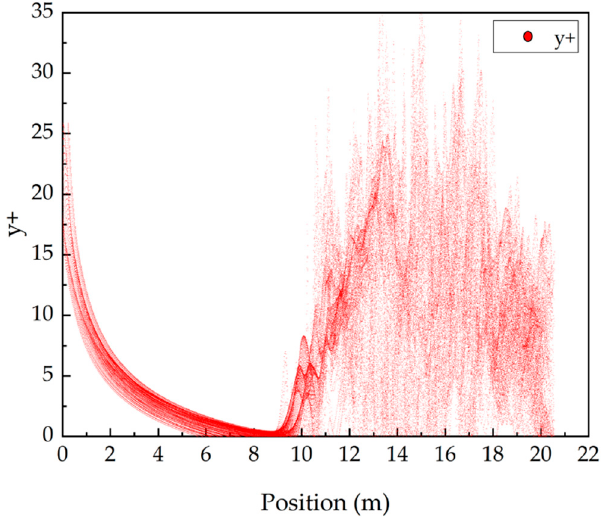
Figure 6. y+ along the pipeline. Figure 6. y + along the